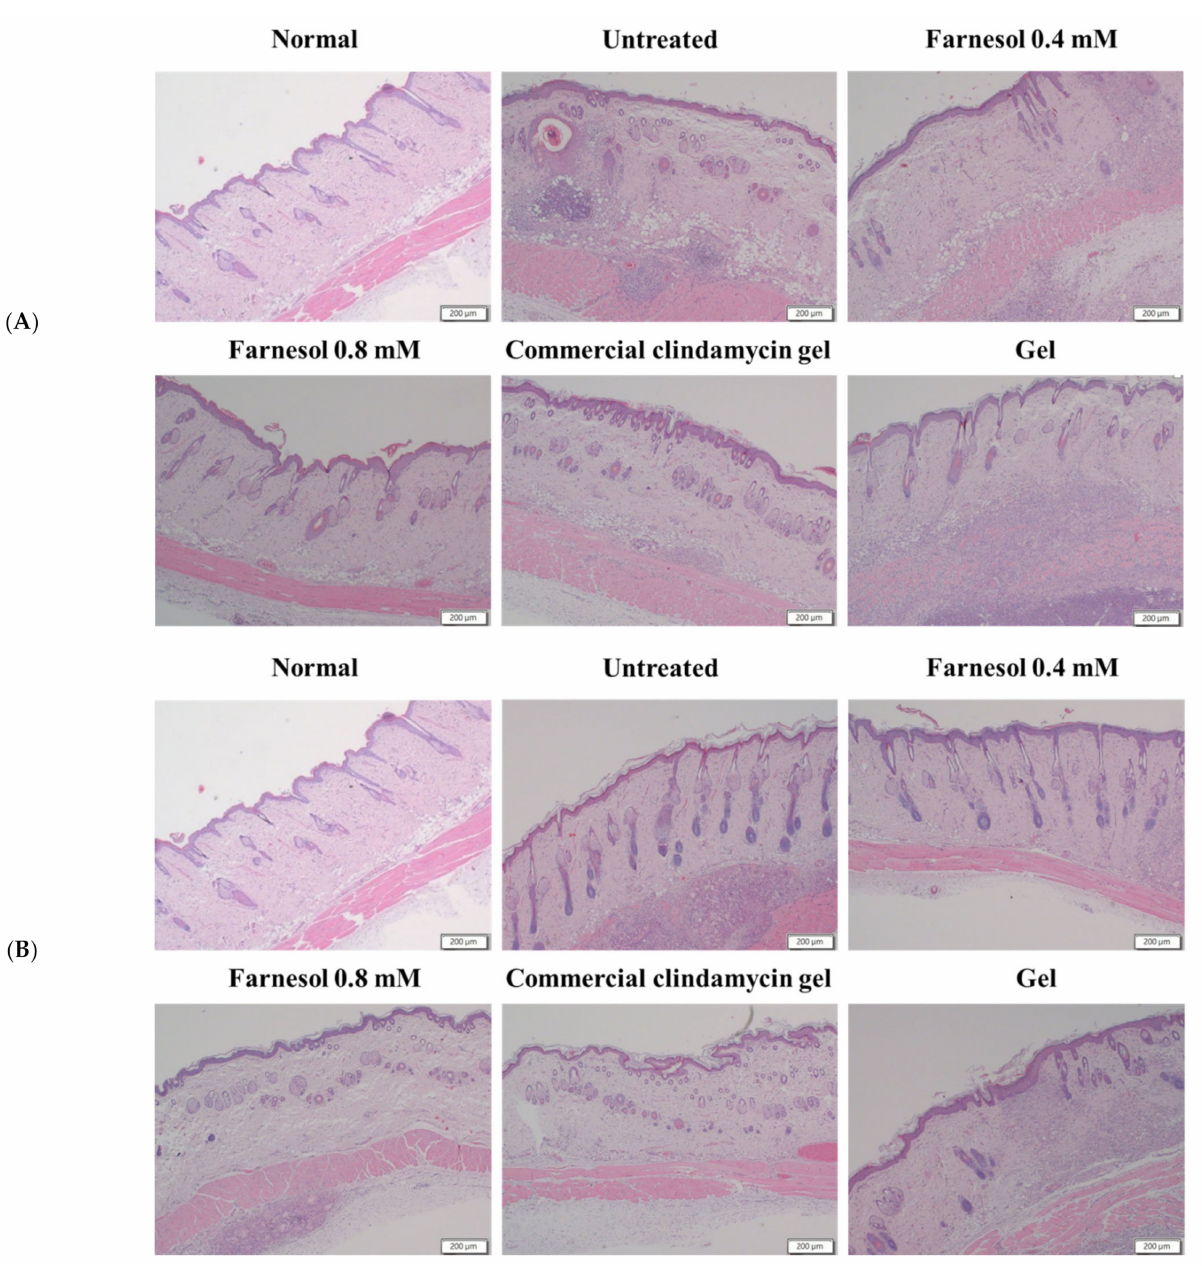
Figure 4. H&E stains of the dorsal skin of rat after two-time ( A ) and four-time ( B ) treatment with 0.4 mM farnesol, 0.8 mM farnesol, HPMC, and commercial clindamycin